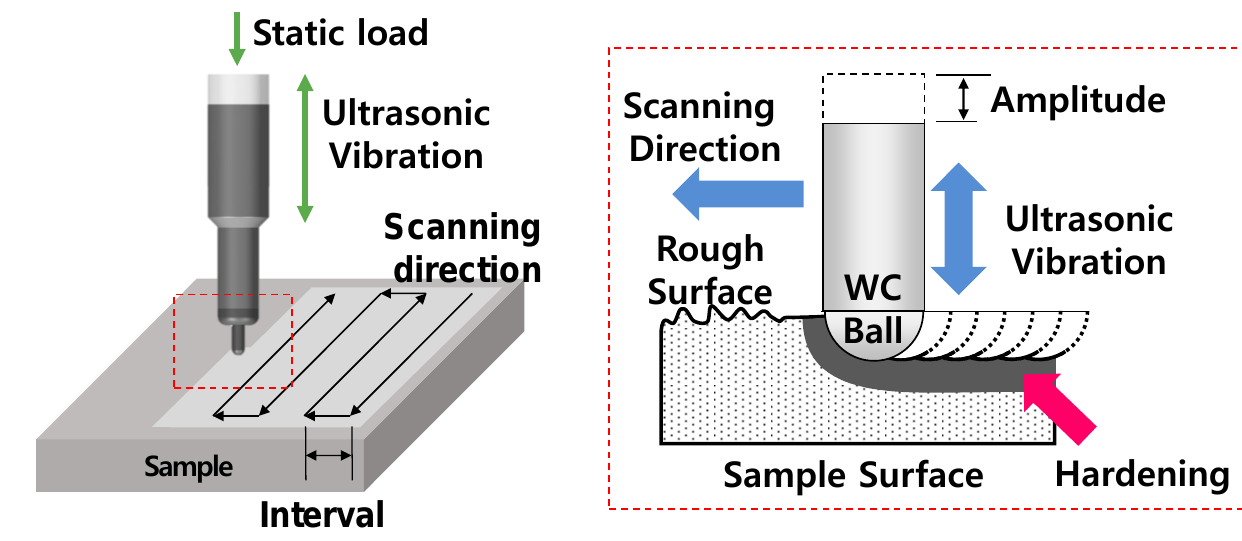
Figure 1. Schematic diagram of UNSM technology.